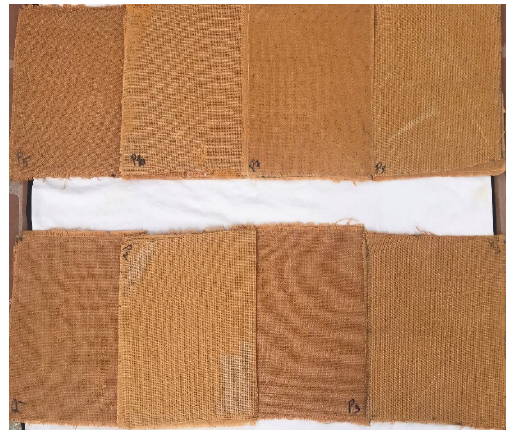
Figure 3. Fabricated